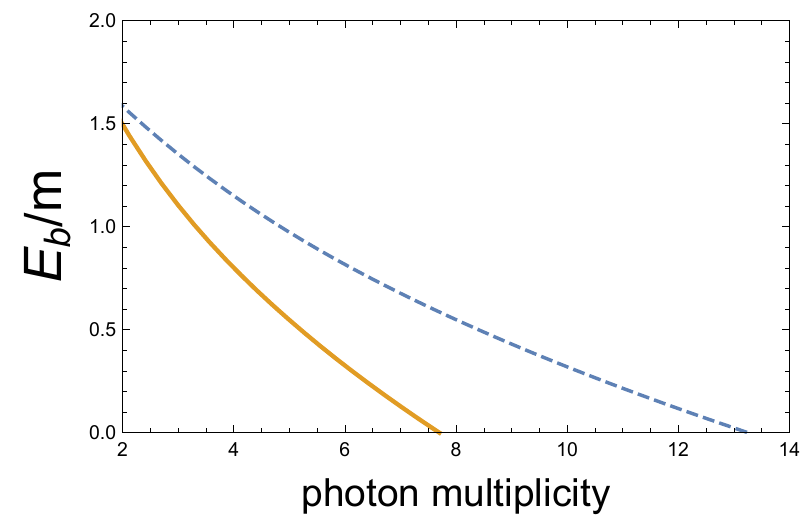
Figure 8. Binding energy in units of monopole mass as a function of average photon multiplicity in the annihilation. The solid curve represents the calculation with interference factor while the dashed curve is that without that